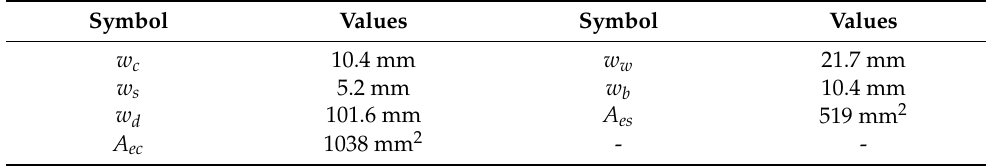
Table 2. The Sizes of the magnetic core.